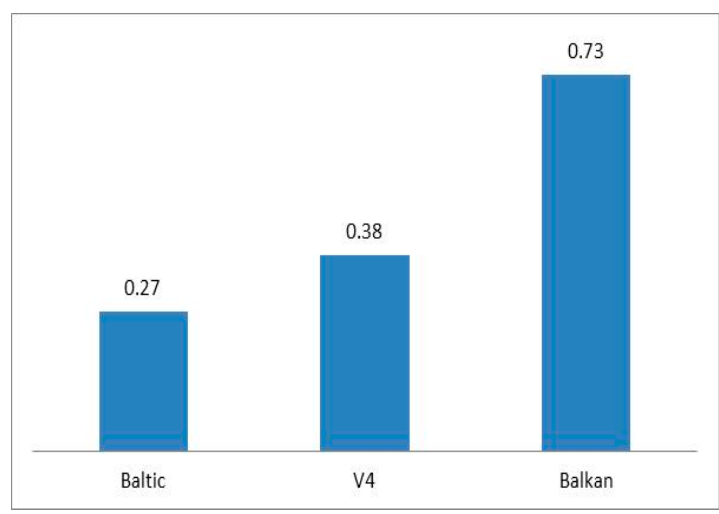
Figure 1. Average Efficiency1 of V4, Baltic and Balkan countries. Source: Author’s own processing.